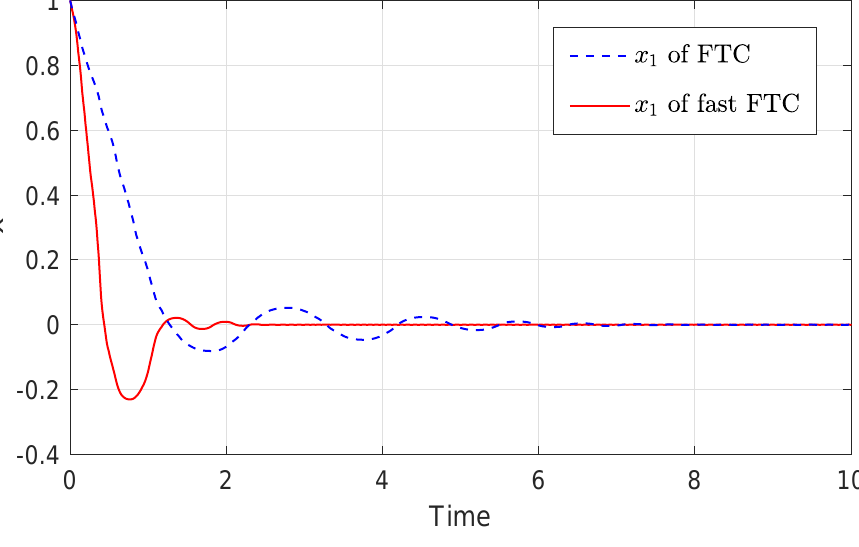
Figure 1. Thetrajectories of x 1 ( t )